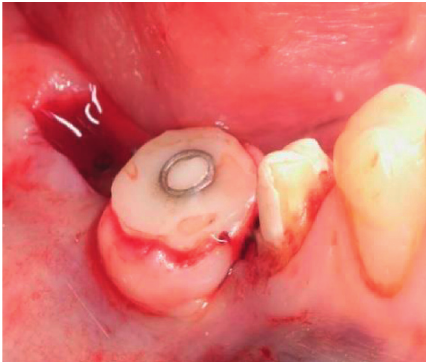
Figure 8: Intraoperative placement of a provisional composite abutment.